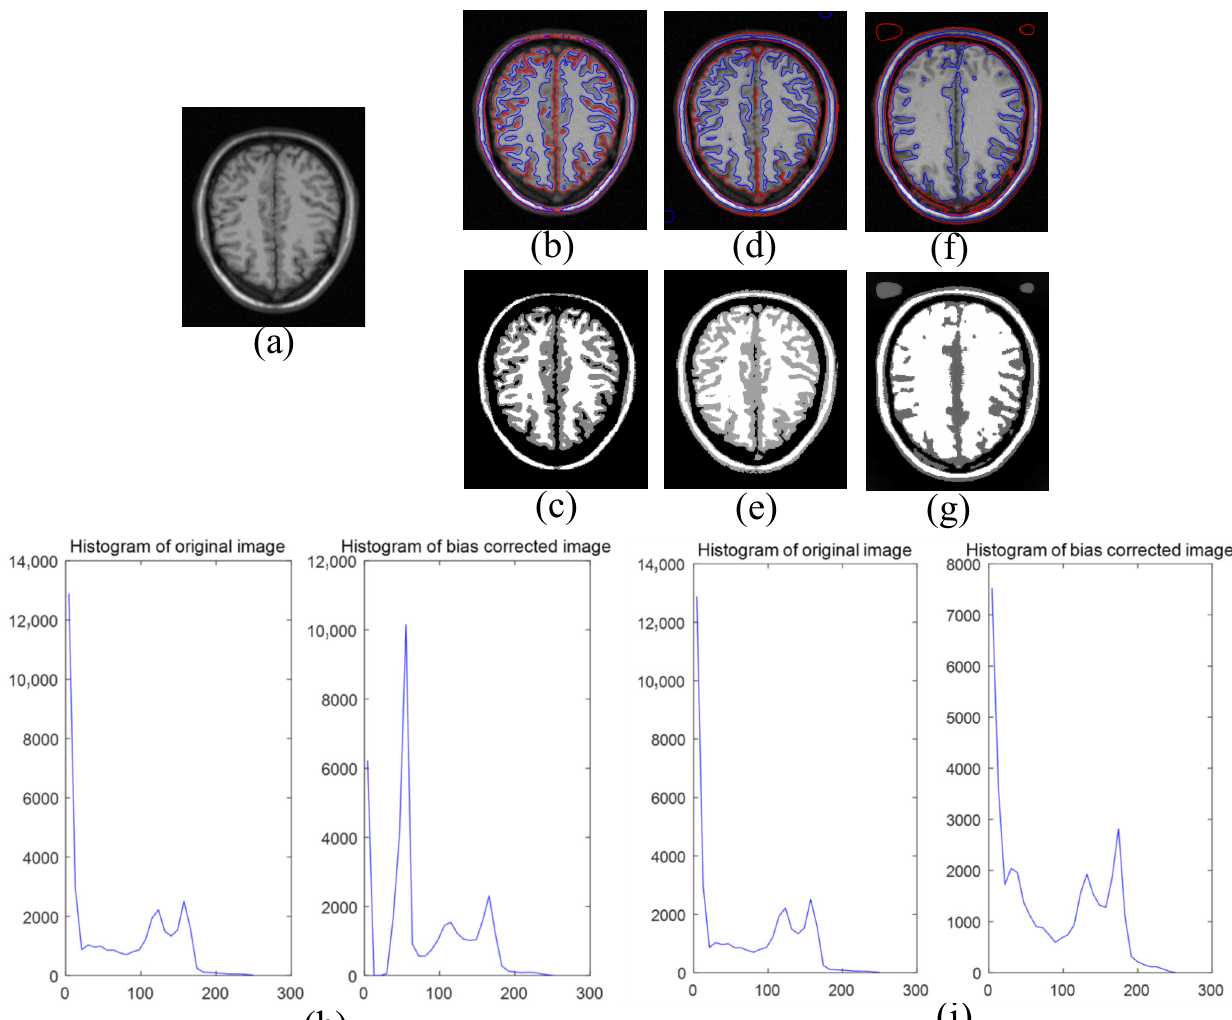
Figure 11. Performance of multiphase level set function and compared with the LIC model and the ALFB model. ( a ) Original image; ( b ) the results of our model; ( c ) the ground truth of our model; ( d ) the result of LIC model; ( e ) the ground truth of LIC model; ( f ) the result of ALFB model; ( g ) the ground truth of ALFB model; ( h ) the histogram of the original image and our model; and ( i ) the histogram of the original image and LIC model.